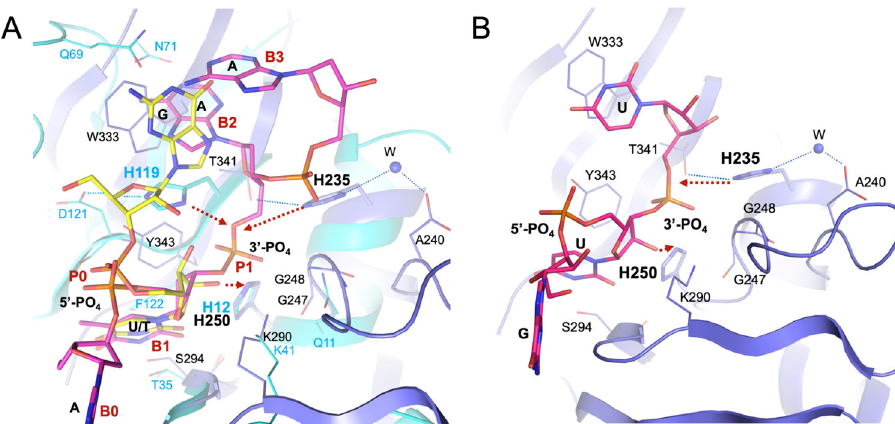
Fig. 7 Comparison of Nsp15 and RNase A active sites. A Nsp15/5 ’ GpU complex compared with RNase A/5 ’ dApdTpdApdA complex (PDB id 1RCN). The least square superposition is calculated with the Nsp15/RNase A residues H250/H12, S294/T35, K290/K41, and U/T bases using COOT (RMSD 0.6 Å on C α atoms). Nsp15 is shown in dark blue, RNase A in aqua, 5 ’ GpU in yellow and 5 ’ dApdTpdApdA oligonucleotide in pink. Base positions B0-B3 and phosphoryl groups positions P0 and P1 are indicated in red (bold). B Model of 5'GpUpU oligonucleotide binding to the Nsp15 active site. Red arrows show proton fl ows (extraction and donation) in A & B